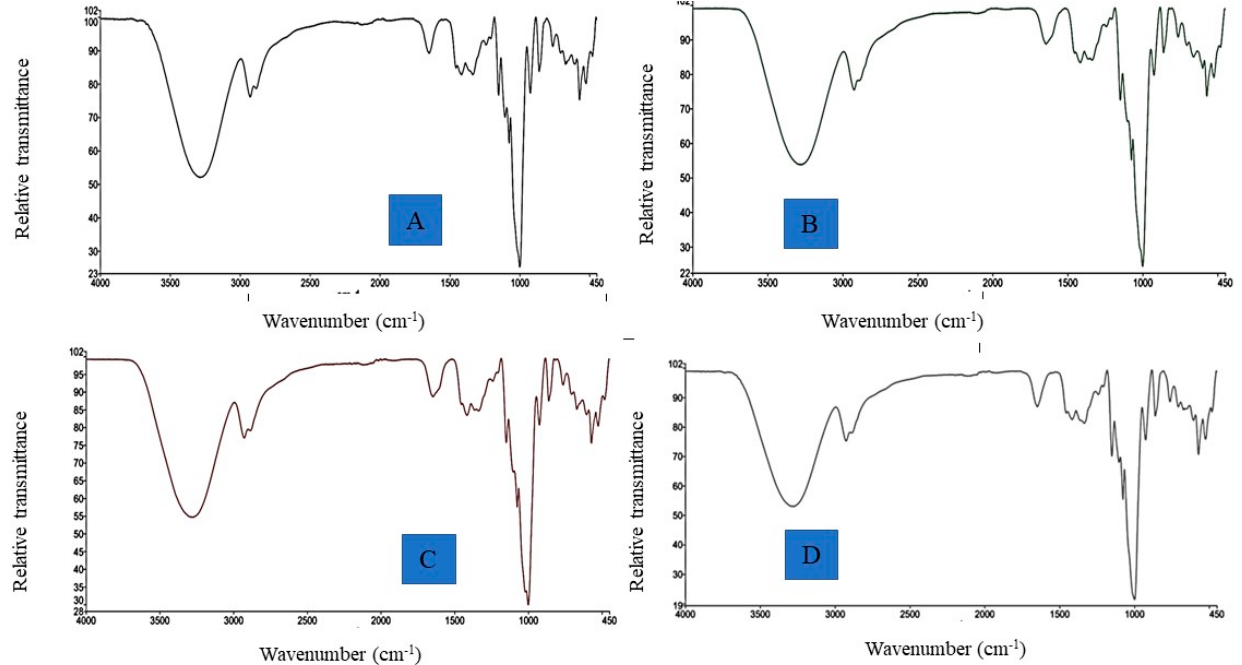
Figure 5. FTIR spectra of native and modified cross ‐ linked lotus seed starch films. ( A ) Native LSF, ( B ) CL ‐ LSF ‐ 1, ( C ) CL ‐ LSF ‐ 3, ( D ) CL ‐ LSF ‐ 5.